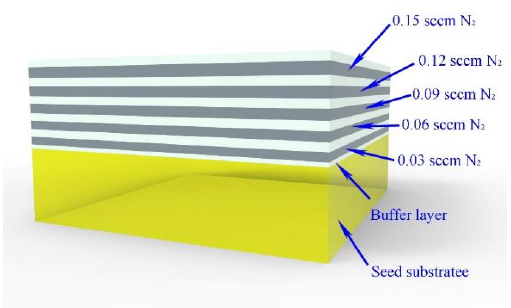
Figure 1. Schematic of the chemical vapor deposition (CVD) layers of sample 1 with various amounts of added N 2 . The white and light gray layers correspond to the buffer and the nitrogen-doped layers, respectively. The yellow part corresponds to the Ib-type high-pressure high temperature (HPHT) seed substrate.